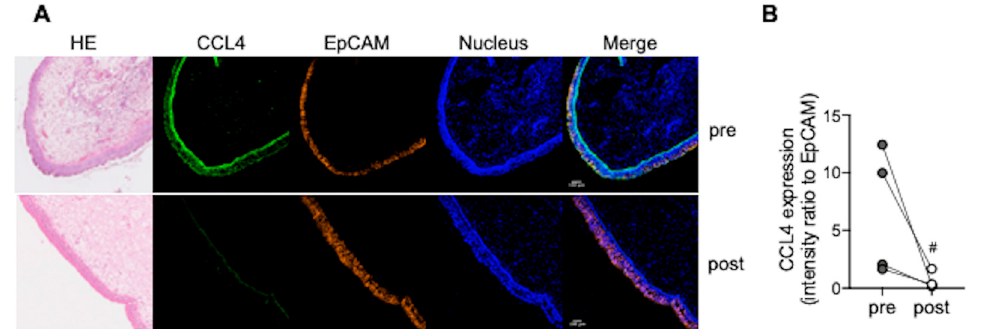
Figure 4. CCL4 expression in nasal polyps. ( A , B ) Nasal polyps were obtained from patients with ECRS by excision biopsy under local anesthesia in the outpatient clinic. CCL4 and EpCAM expression in nasal polyps were evaluated pre- and post-treatment with dupilumab. Hematoxylin & Eosin (HE) staining; CCL4 (green), EpCAM (orange), and the nucleus (blue) are shown in upper (pre-treatment)